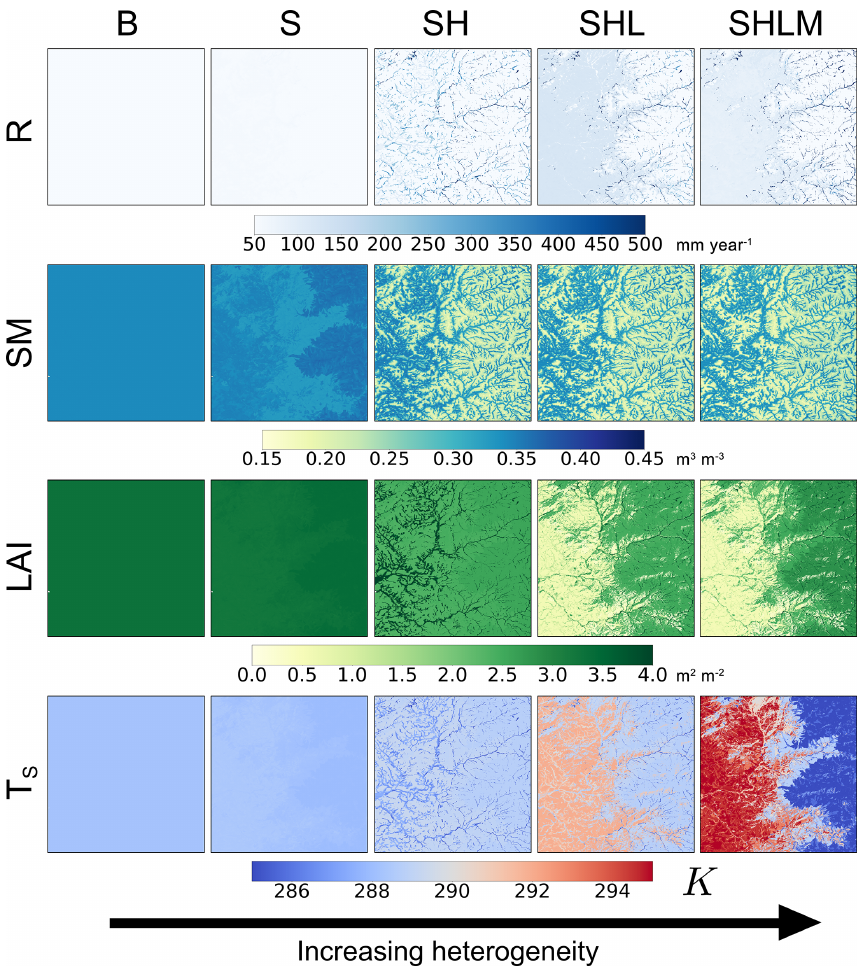
Figure 10. Visual comparison of the mapped annual mean (2002–2014) of simulated runoff ( R ), 2m root zone soil moisture (SM), leaf area index (LAI), and soil temperature ( T s ) for the five model experiments in Table